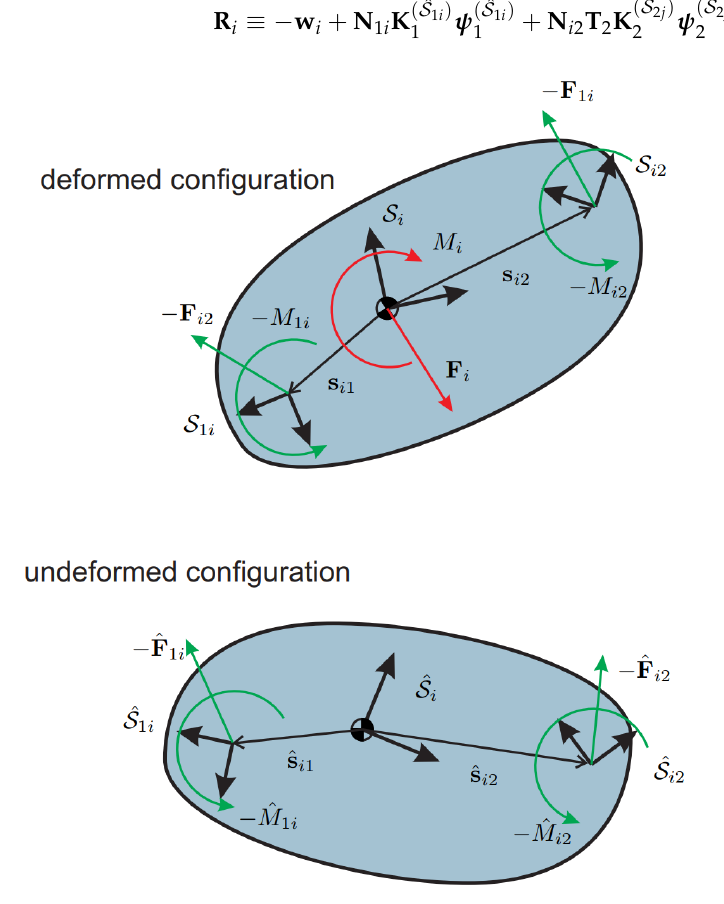
Figure 4. Kinetostatic balance of a